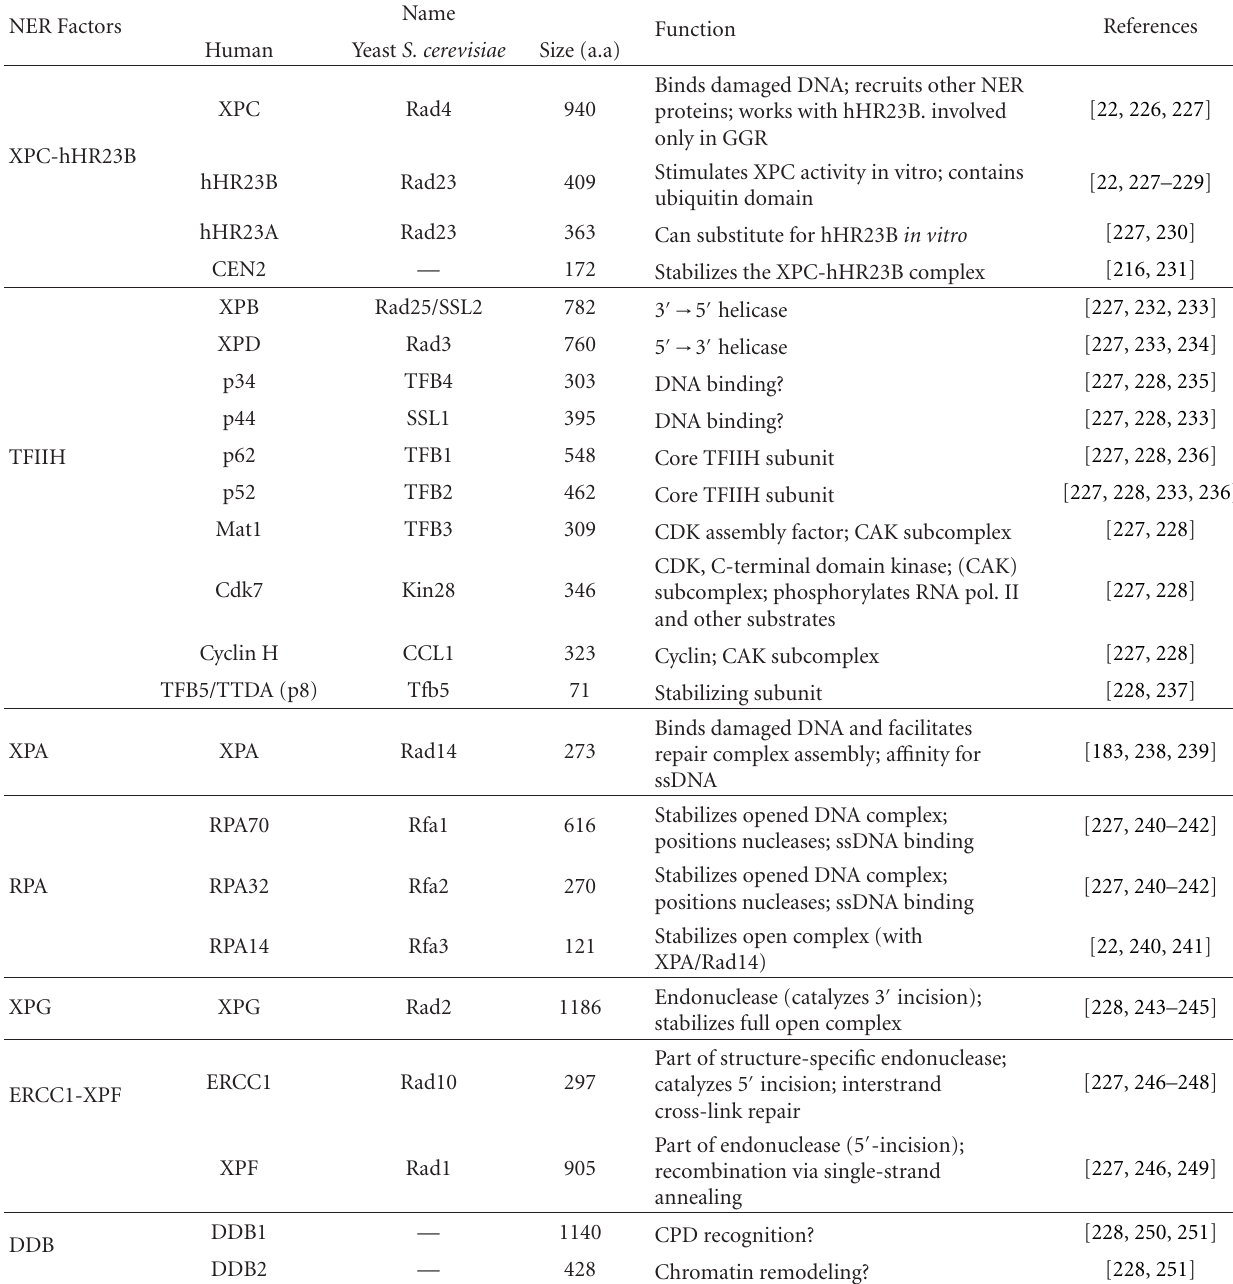
Table 4: NER proteins and their probable role in human and S.